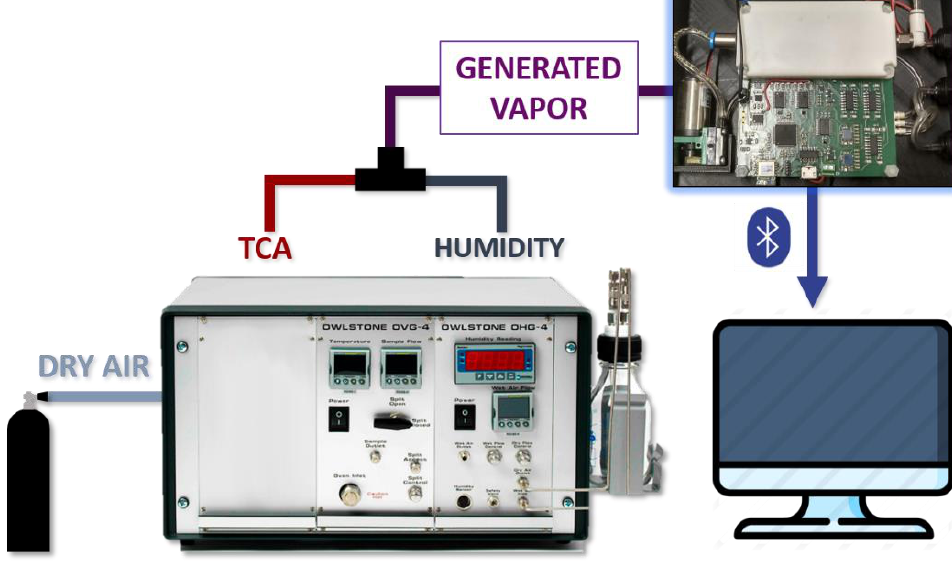
Figure 4. Experimental